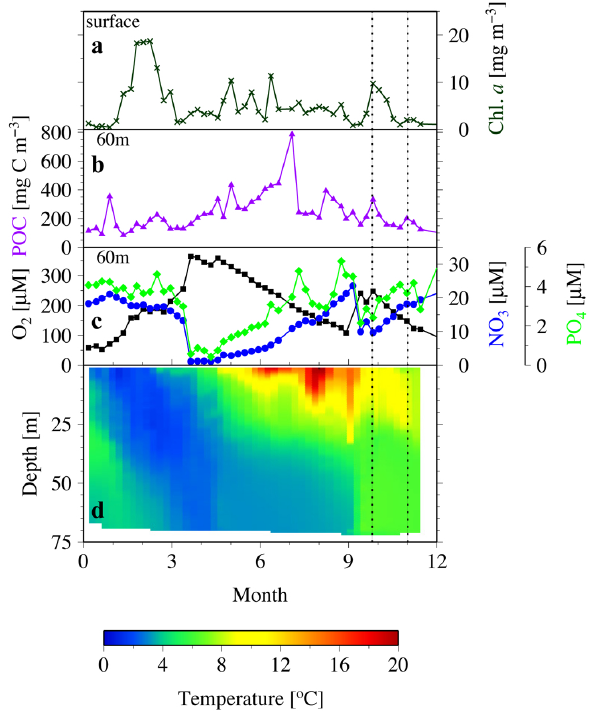
Fig. 4. Time series of surface Chl a (a) , deep-water particulate or- ganic carbon (POC) (b) , deep-water oxygen and nutrients (c) , and temperature depth profiles (d) in Bedford Basin during 2010. Black dashed lines indicate the sampling period of the study.